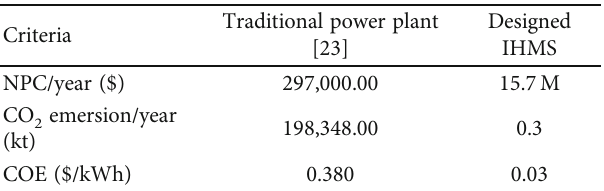
Table 3: Comparison of di ff erent criteria between the designed and traditional